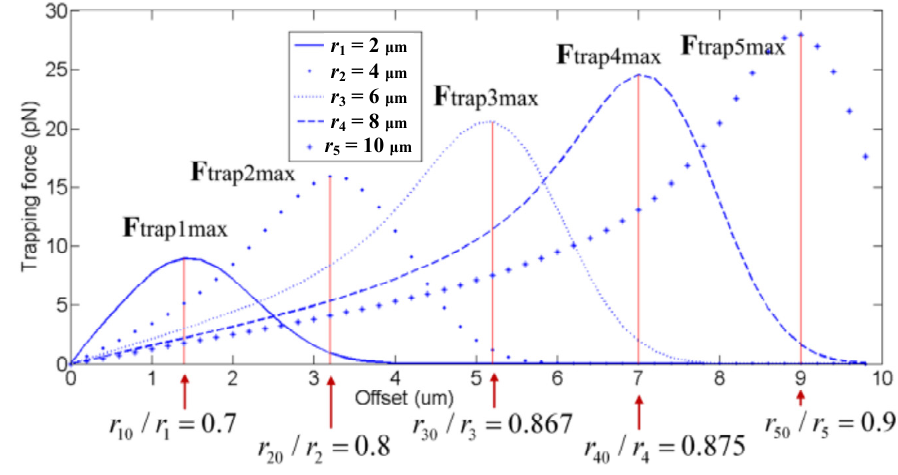
𝑟 (cid:3036)(cid:2868) r i 𝑟 (cid:3036) (cid:3415) [43].